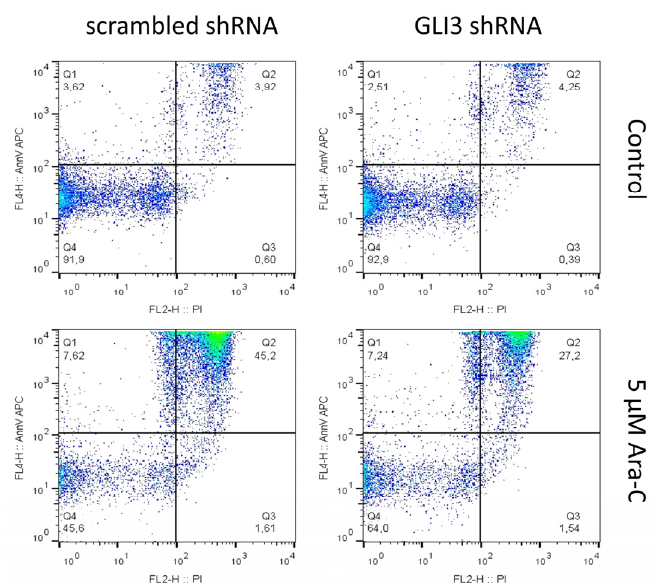
Figure A4. Representative flow cytometry plots for the treatment of THP-1 cells transduced with GLI3 -targeted shRNA or scrambled shRNA control with 5 µ M Ara-C. Induction of apoptosis was measured after 48 h by flow cytometry using Annexin V-APC and propidium iodide.